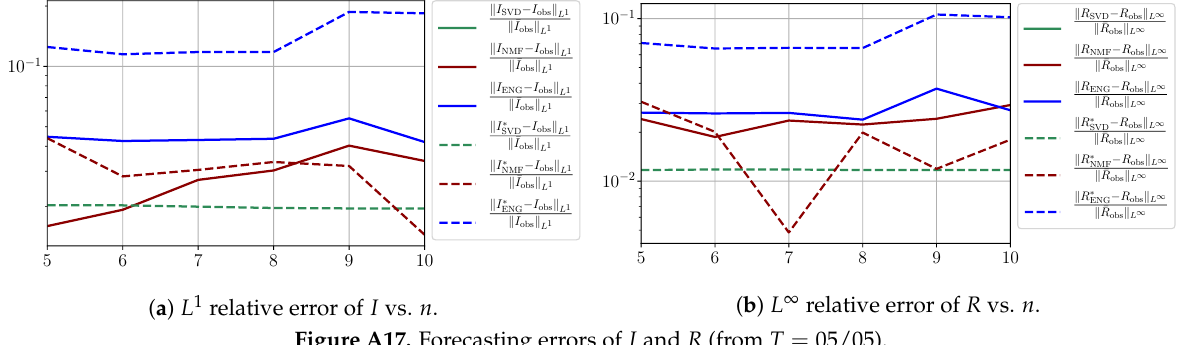
Figure A17. Forecasting errors of I and R (from T = 05/05). We observe that the quality of the forecast depends on the reduced basis but also strongly on the starting day T from which the forecast is produced. The forecasts us- ing routine- βγ with SVD and NMF are not accurate and most often blow up. When routine-IR is used with SVD and NMF, the forecasts are more robust as there is no ob- served explosion of error. Reduced bases from ENG consistently lead to the the best forecast being obtained using either routine- βγ and routine-IR ; by inspecting the error on Figures A9–A17 and the averaged forecasts obtained in Section 4.2.1, we conclude that routine- βγ with ENG-reduced bases provides slightly better